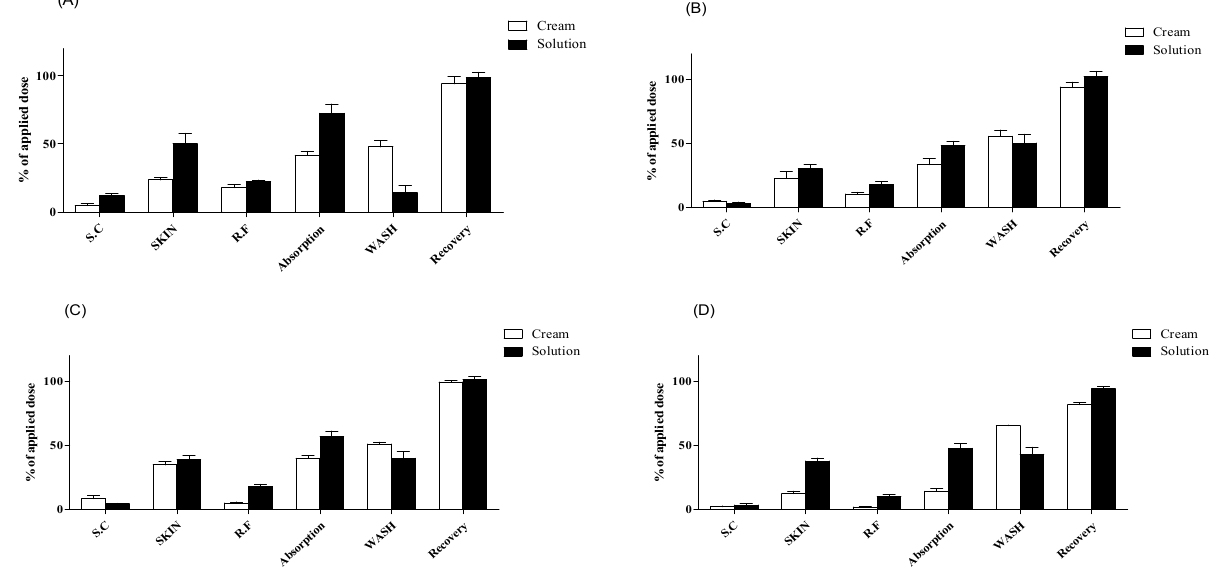
Figure 3. Dermal absorption of testosterone in rat skins (n = 4, mean ± SD). Dermal absorption test results with doses of ( A ) 5 mg/cm 2 or 5 µ L/cm 2 , ( B ) 10 mg/cm 2 or 10 µ L/cm 2 , ( C ) 25 mg/cm 2 or 25 µ L/cm 2 , and ( D ) 50 mg/cm 2 or 50 µ L/cm 2 . SC, stratum corneum; SKIN, dermis and epidermis; RF, receptor fluid; WASH, remaining formulation rinsed using alcohol swabs.